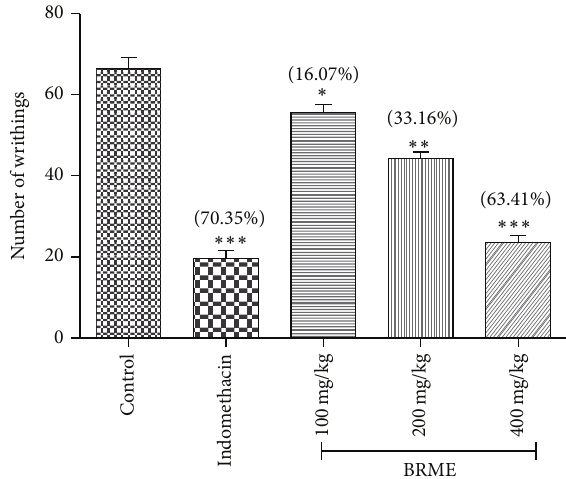
Figure 2: Effects of BRME and indomethacin in the acetic acid- induced abdominal writhing test in mice. Values are expressed as means ± SEM ( 𝑛 = 6 ). ∗ 𝑃 < 0.05 , ∗∗ 𝑃 < 0.01 , and ∗∗∗ 𝑃 < 0.001 , compared to the control